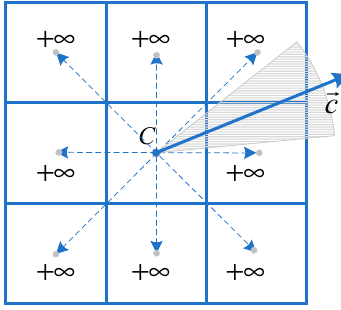
Figure 3. The intersection of the reachable region and allowed motion directions based on traditional path planning algorithm is empty. Some of the physically feasible moves exist in the continuous domain (gray sector). Nevertheless, all neighbors of C are tagged as unreachable in the discrete domain.